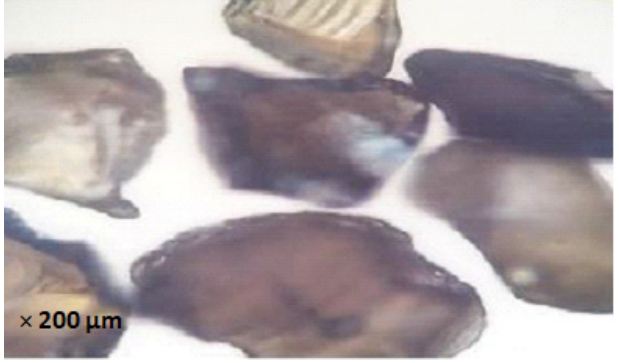
Figure 5. Morphology of SiC particles using corrosion-abrasion.